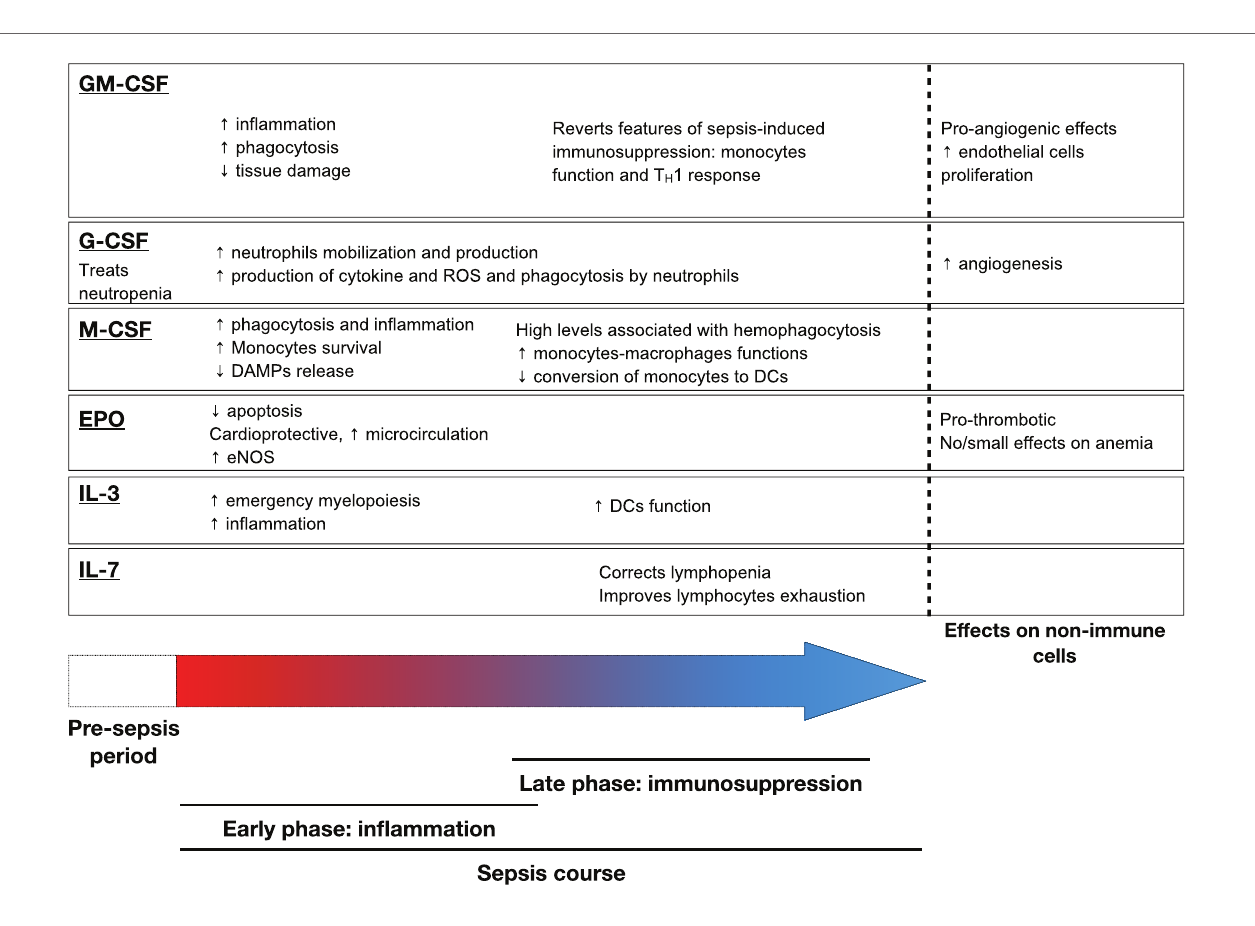
FiGURe 2 | Main effects of hematopoietic growth factors during sepsis. Abbreviation: GM-CSF, granulocyte macrophage – colony stimulating factor; EPO, erythropoietin; IL-3, interleukin-3; IL-7, interleukin-7; DAMP, damage-associated molecular pattern; DC, dendritic cell; ROS, reactive oxygen species; eNOS, endothelial Nitric oxide